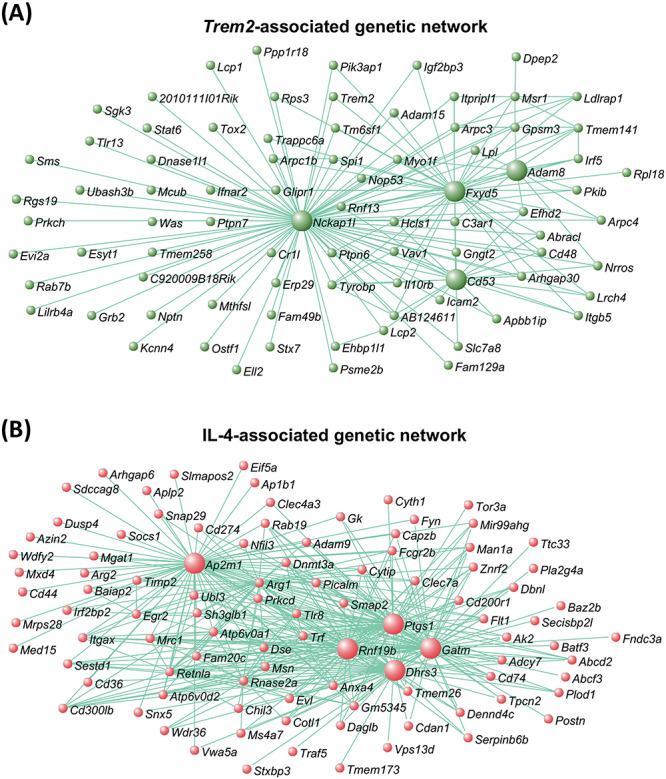
Co-expression genetic networks associated with Trem2 expression and IL-4-treatment. (A) Co-expression network associated with Trem2 expression, using RNA-seq derived gene expression from primary microglia of Trem2 R47H KI and WT mice. Network contains key genes mediating microglial functions, and includes Trem2, Spi1/PU.1, Tyrobp and Stat6. Larger green spheres represent ‘hub’ genes, those showing the greatest number of connections to other genes in the network, which are likely to play important roles in driving microglial functions alongside Trem2. (B) Co-expression network associated with IL-4-treatment, using RNA-seq derived gene expression from primary microglia treated with IL-4 and untreated. Network includes key genes involved in anti-inflammatory processes, such Arg1, Retnla and Chil3. Larger red spheres represent ‘hub’ genes, which are likely to play important roles in driving the microglial response to IL-4. N = 3 mice per genotype per condition.